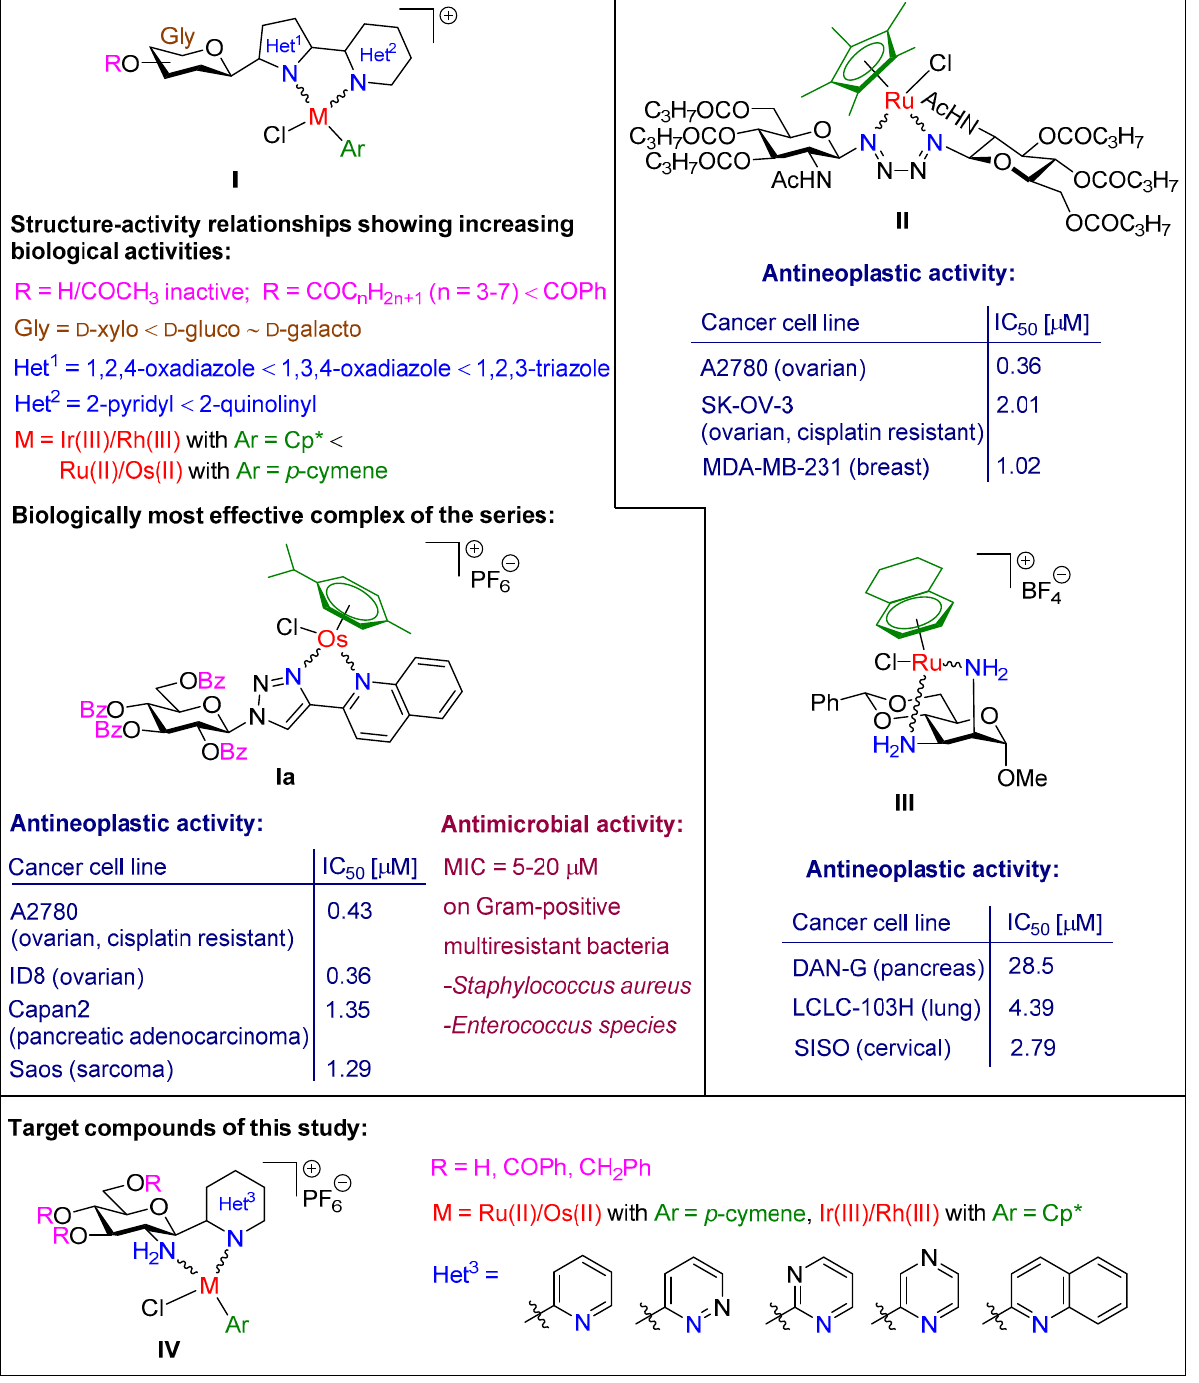
Figure 1. Preliminaries and target compounds of the present work.